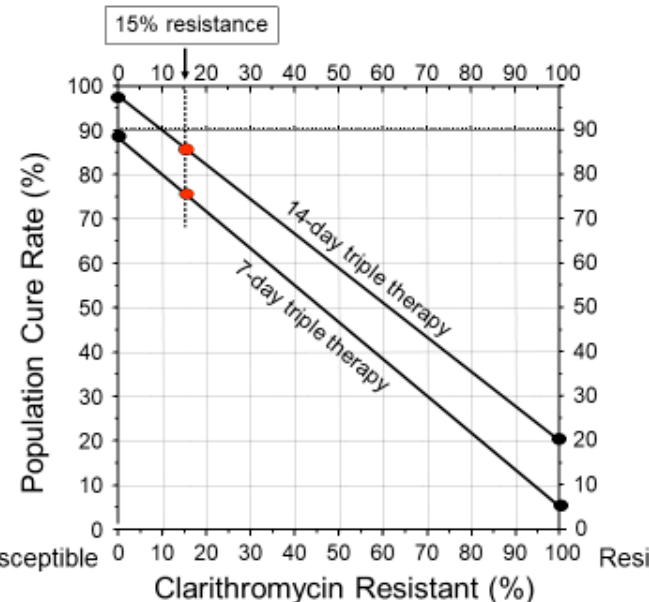
Figure 2. Helicobacter pylori treatment nomogram illustrating the duration-related di ff erence in cure rate with 7- and 14-day clarithromycin triple therapy and the e ff ect of clarithromycin resistance on the outcome. As shown, 15% clarithromycin resistance results in a decline in the population cure rate to approximately 85% with 14-day therapy and to approximately 75% with 7-day therapy. It also shows the lack of utility of consensus conference recommendations to use 15% resistance as a yes-no guide to